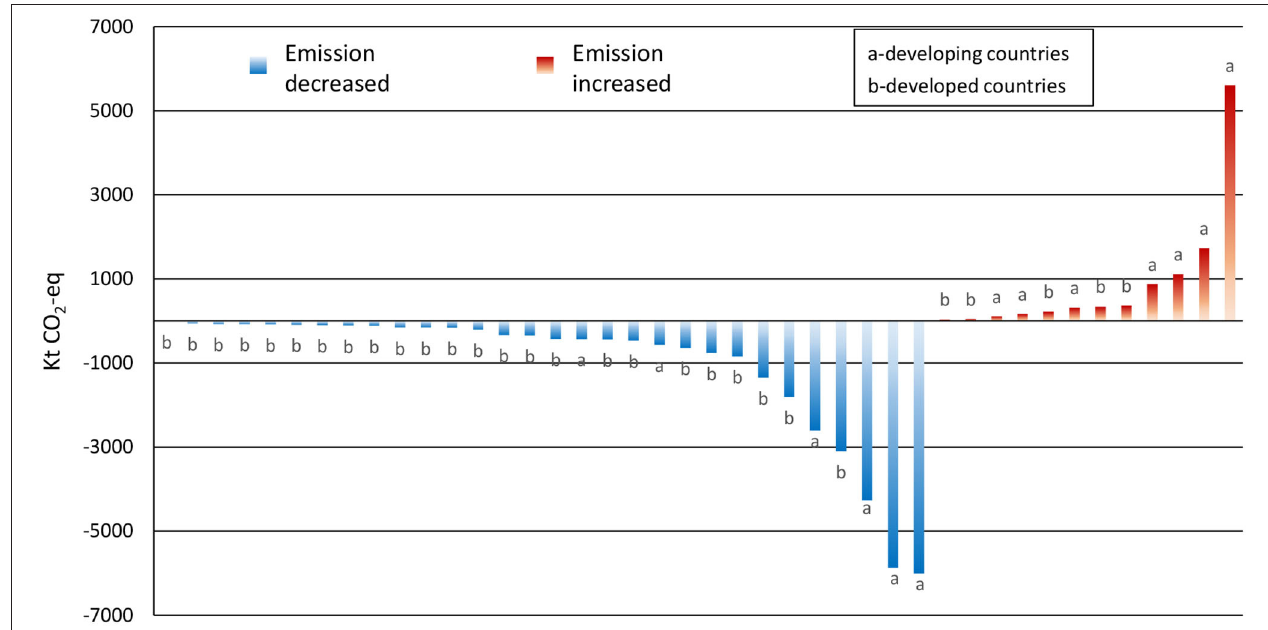
FIGURE 3 | Annual change of GHG emission in cities over 2005–2016. 1, Yokohama; 2, Vancouver; 3, Stockholm; 4, Paris; 5, Sydney; 6, San Francisco; 7, Milan; 8, Barcelona; 9, Boston; 10, New Orleans; 11, Austin; 12, Washington, DC; 13, Copenhagen; 14, Athens; 15, Los Angeles; 16, Durban; 17, Toronto; 18, Chicago; 19, Chennai; 20, Philadelphia; 21, Oslo; 22, New York City; 23, Seoul; 24, Seattle; 25, Houston; 26, Amman; 27, London; 28, Istanbul; 29, Bogotá; 30, Bangkok; 31, Auckland; 32, Melbourne; 33, Cape Town; 34, Buenos Aires; 35, Montréal; 36, Ciudad de México; 37, Venice; 38, Madrid; 39, Lima; 40, Curitiba; 41, Johannesburg; 42, Rio de